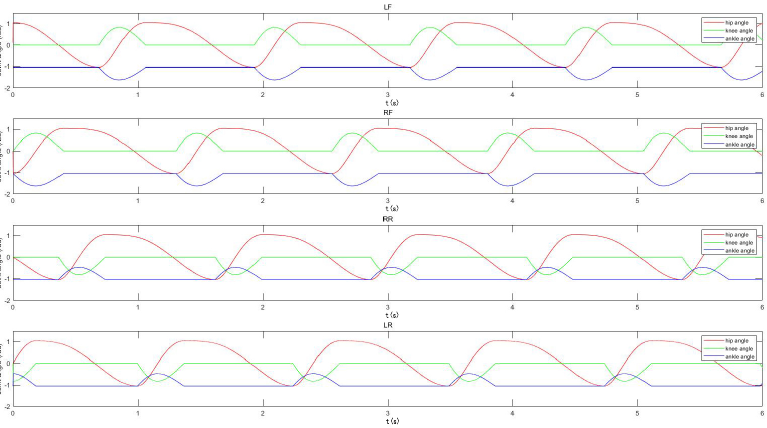
Figure 10. The joint angles in walk gait.